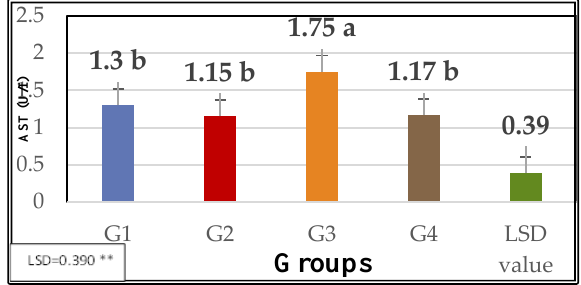
Figure, 2: Effect of Betaine intubation on Aspartate Aminotransferase (AST) Activity in experimental group.